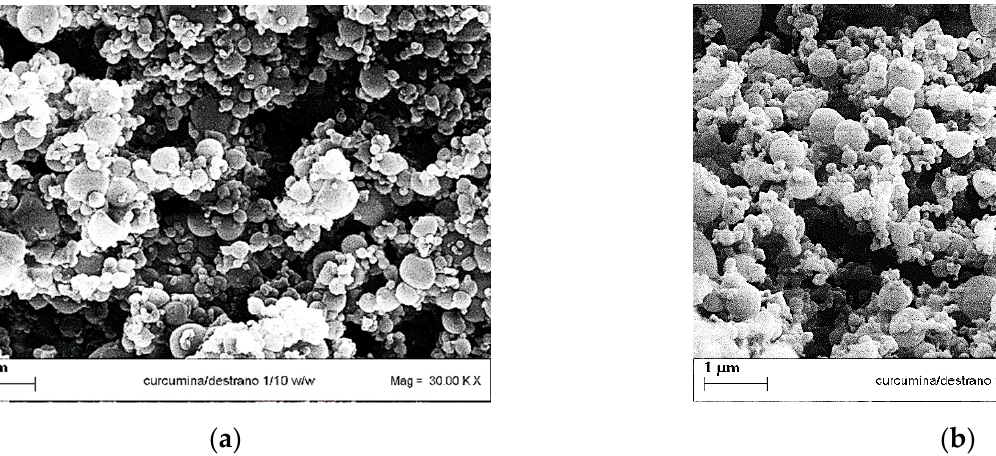
Figure 3. DXT/CUR particles produced by SAA from EtOH/H 2 O 70/30 at 5 mg/mL. Effect of the API/carrier ratio: ( a ) 10/1 w / w ; ( b ) 6/1 w / w .